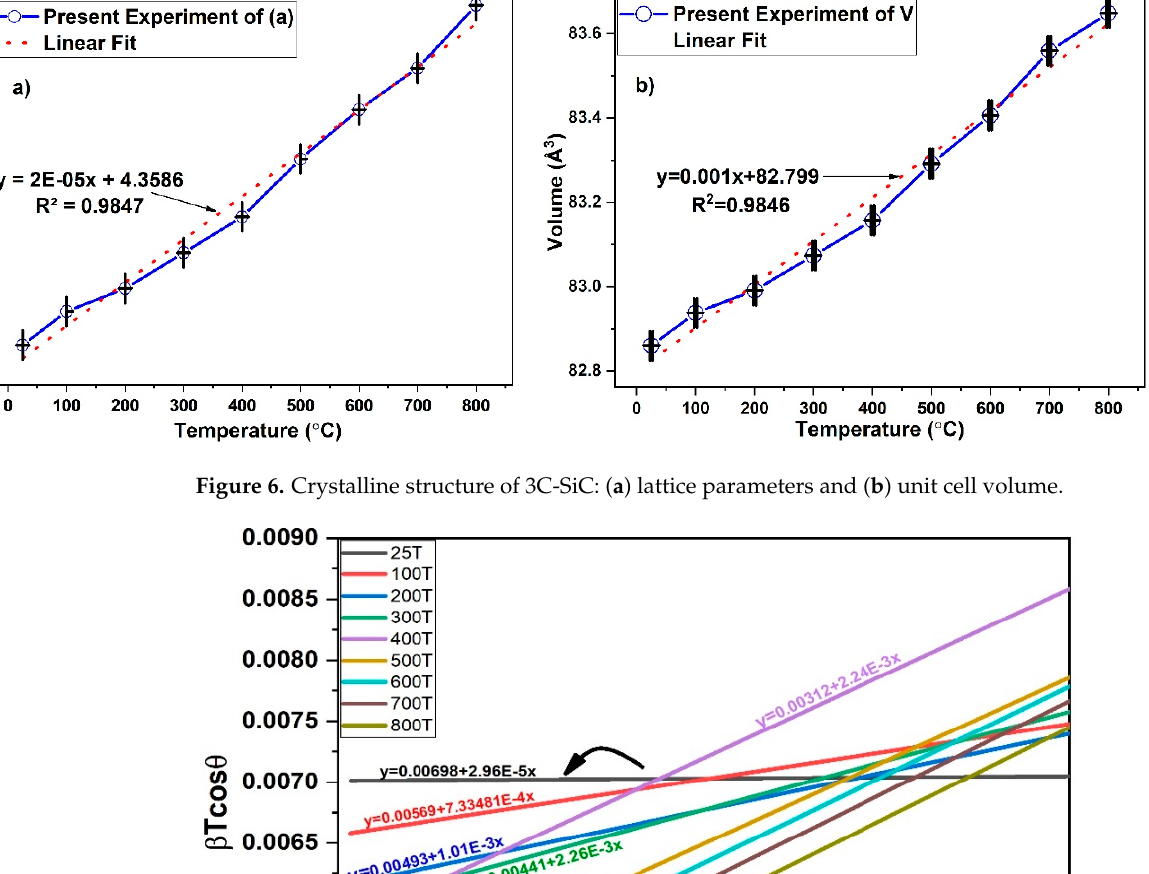
Figure 6. Crystalline structure of 3C-SiC: ( a ) lattice parameters and ( b ) unit cell volume.